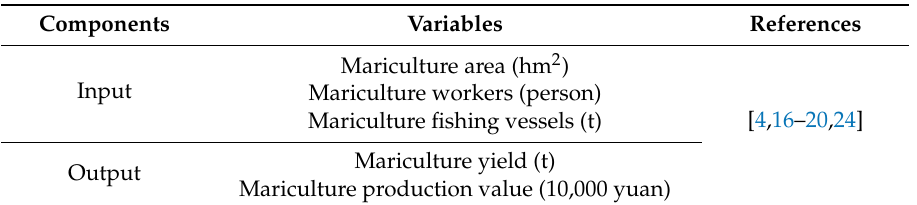
Table 1. Evaluation indicator system of mariculture efficiency.